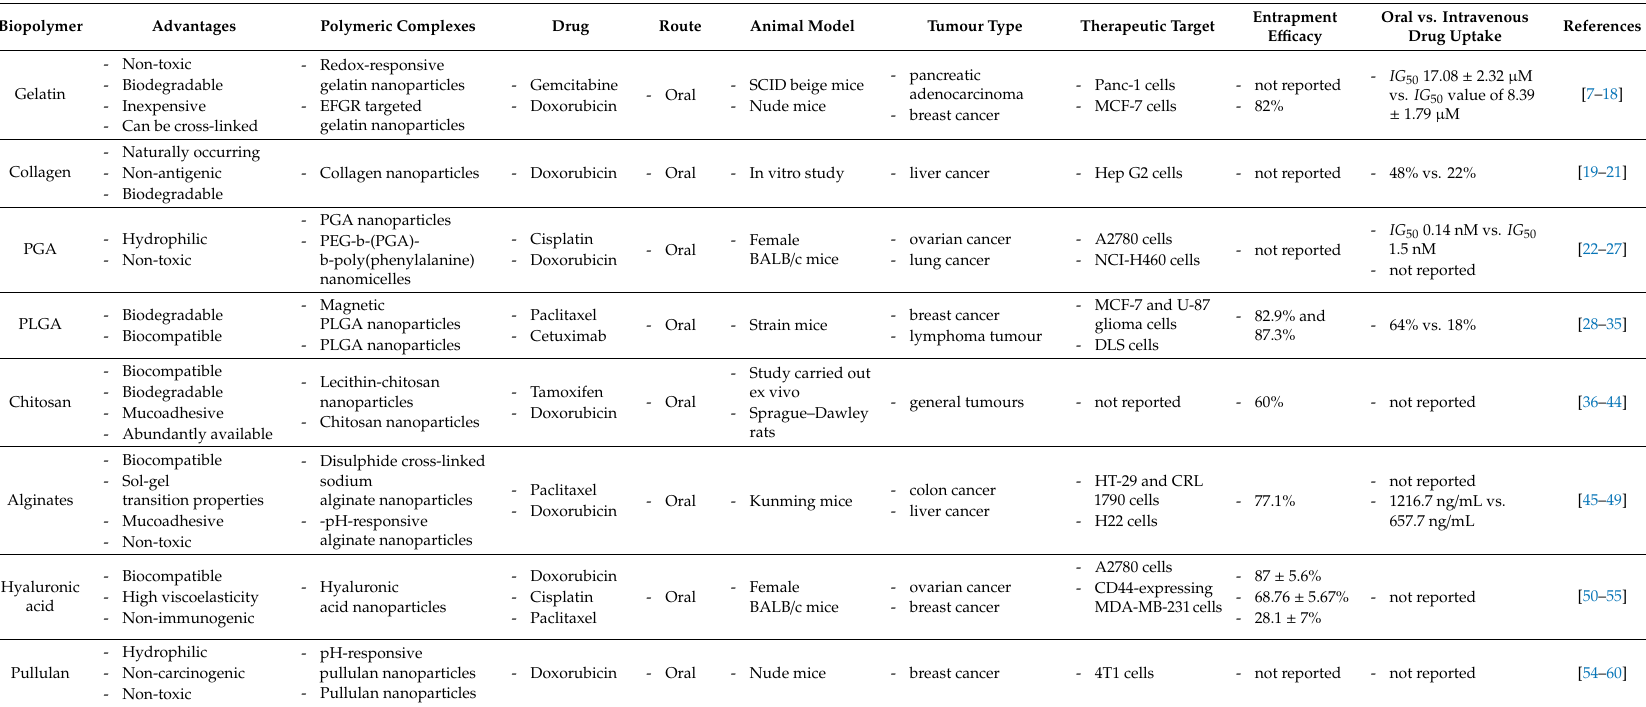
Table 1. Summary of biopolymers, their advantages and possible polymeric